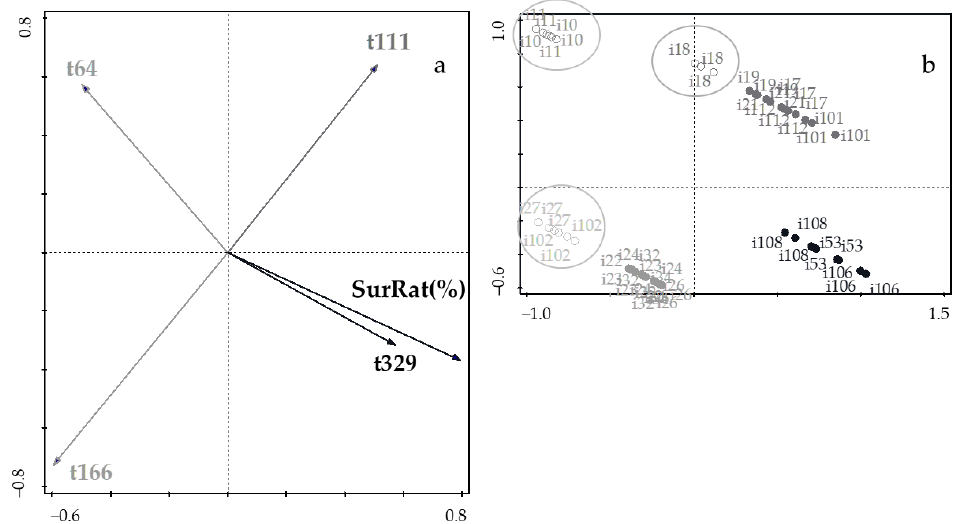
Figure 4. ( a ) Plot of loadings formed by the first two principal components from PCA, pertaining to probiotic characteristics associated with gastrointestinal survival and fermentation time; and ( b ) plot of scores encompassing strains isolated from Cobrançosa table olives.